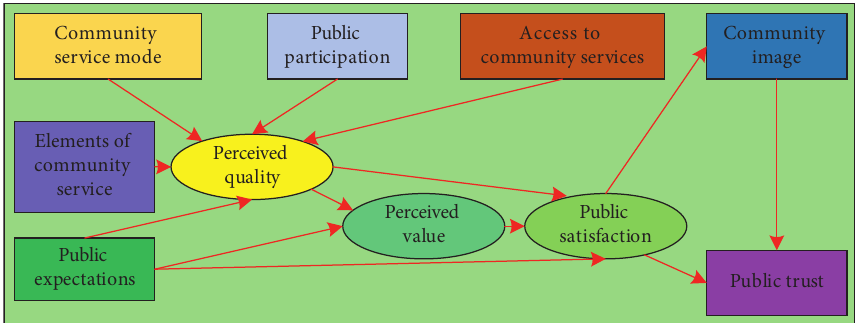
Figure 4: Evaluation model of social service